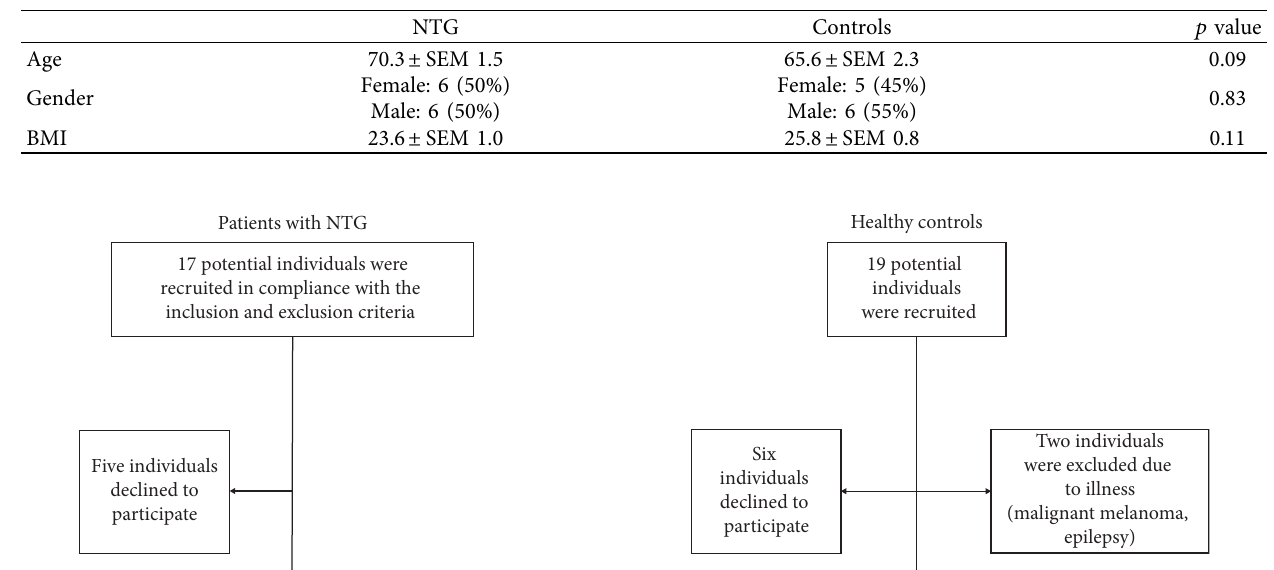
Table 1: Characteristics of participants.